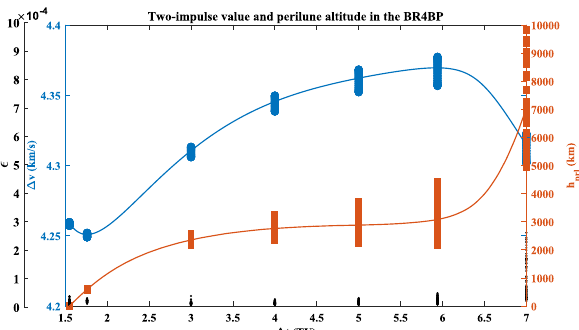
Figure 12. Two-impulse value and perilune altitude oscillate in the planar BR4BP.